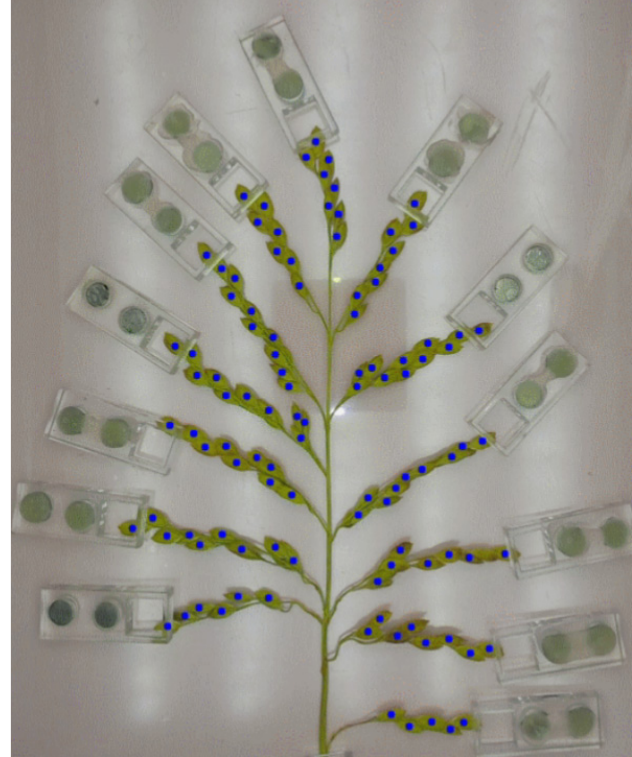
Figure 9. The result of the grain counting algorithm.